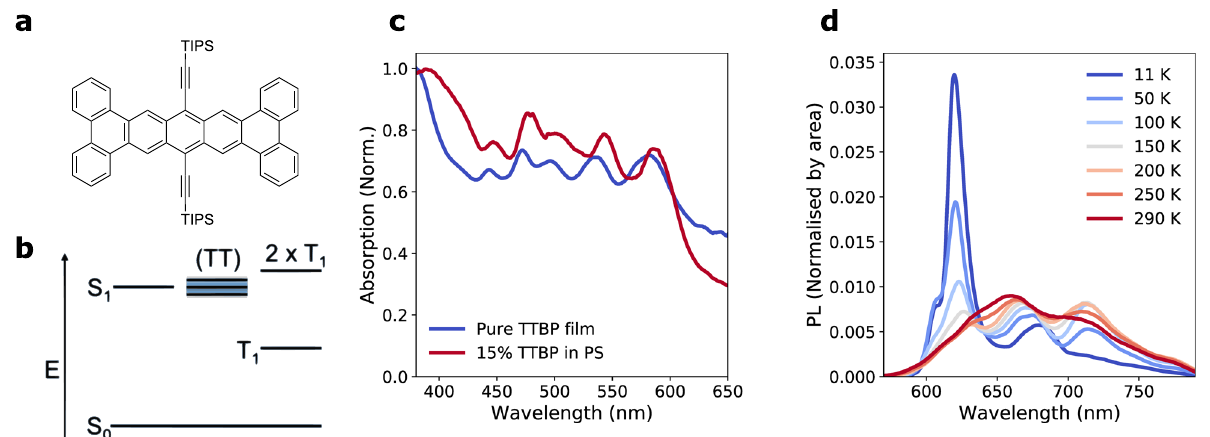
Fig. 1 Molecular structure and stead-state characterisation of TTBP. a Molecular structure of TIPS-tetrabenzo[a,c,l,n]pentacene (TTBP). b Schematic energy level diagram for endothermic singlet fi ssion in TTBP. c Absorption spectrum of a pure TTBP fi lm (blue) and a 15% blend of TTBP in polystyrene (red) at room temperature. The measured absorption at wavelengths longer than ~600 nm is due to scattering and re fl ectance. d Temperature-dependent time-integrated photoluminescence, using a pulsed excitation source at 500 nm, pulse duration 200 fs, 1 kHz repetition, from 11 K to room temperature. Colours blue to red indicate temperature, from lowest (11 K) to highest (290 K).